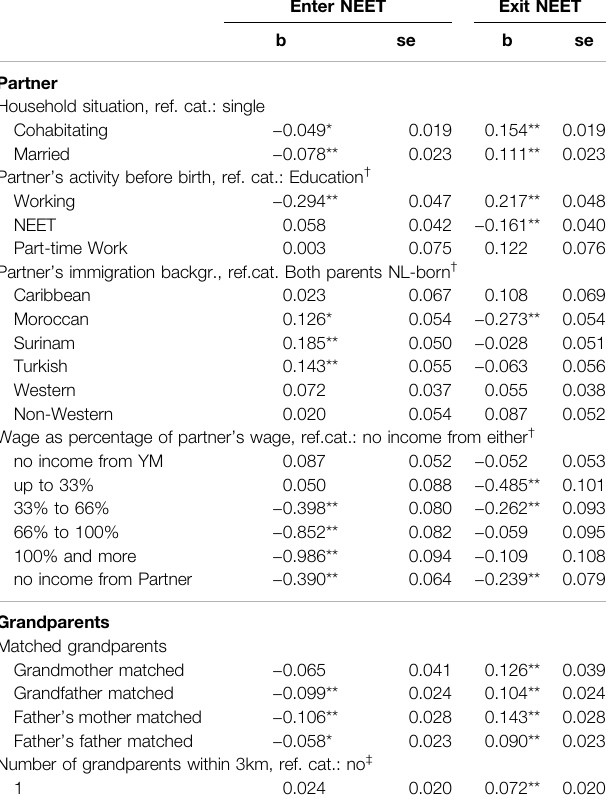
TABLE 5 | ( Continued ) Discrete-time event history analysis of available support by grandparents, log odds form logistic regression of entry into and exit out of